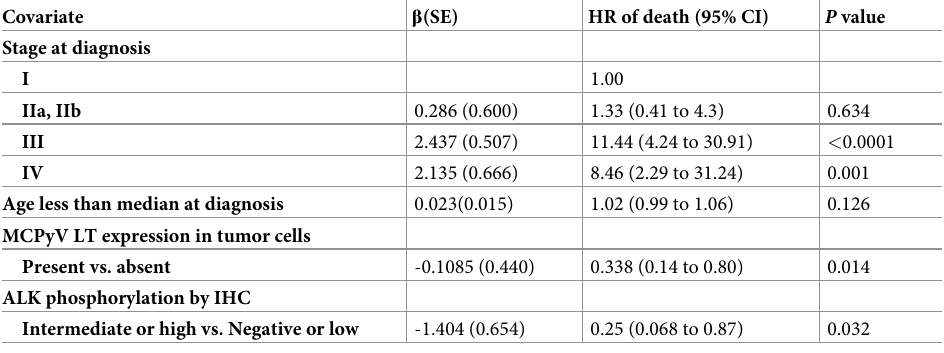
Table 3. Multivariable Cox hazards analysis on MCC-specific survival. Covariate